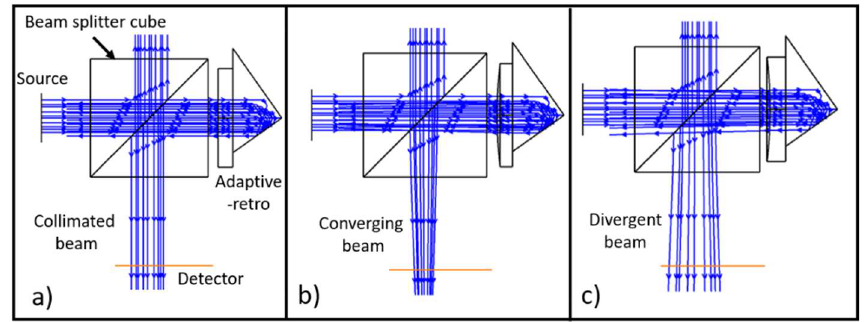
Figure 3. Optical design setup used for testing including the collimated source incident on the beam splitter cube with the outputs: ( a ) a collimated beam, ( b ) a converging beam, and ( c ) a divergent beam.